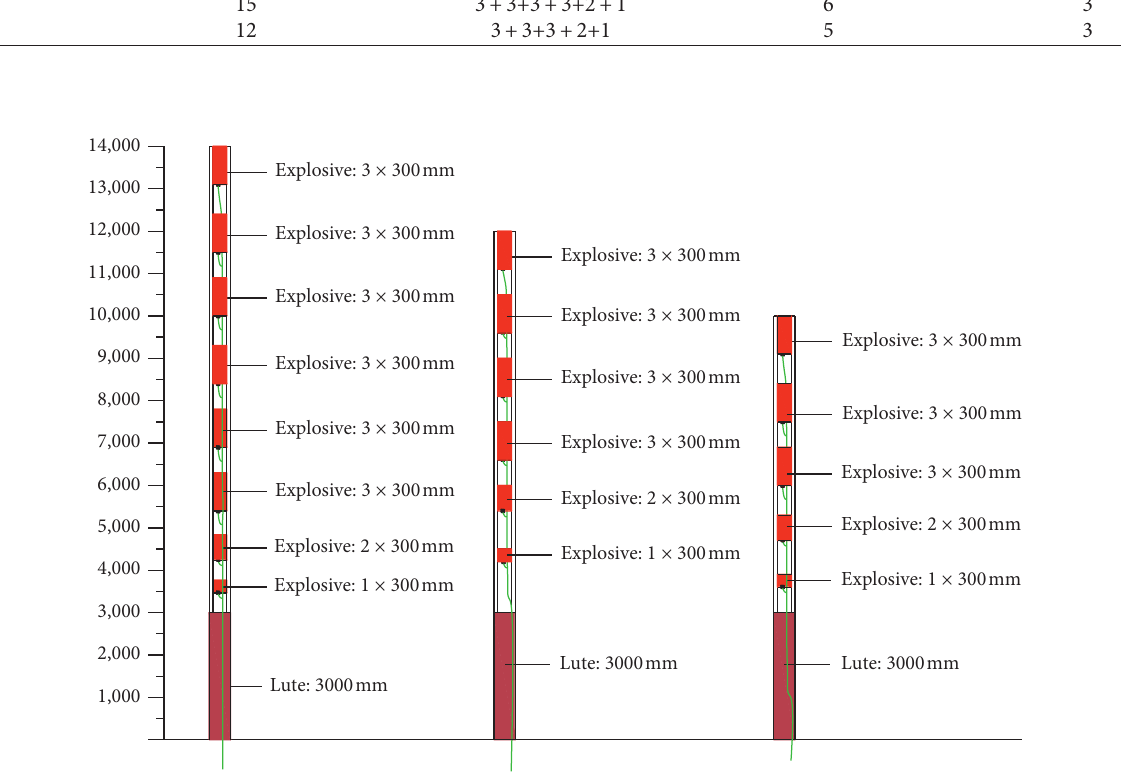
Figure 16: Charge structure chart of blast holes.